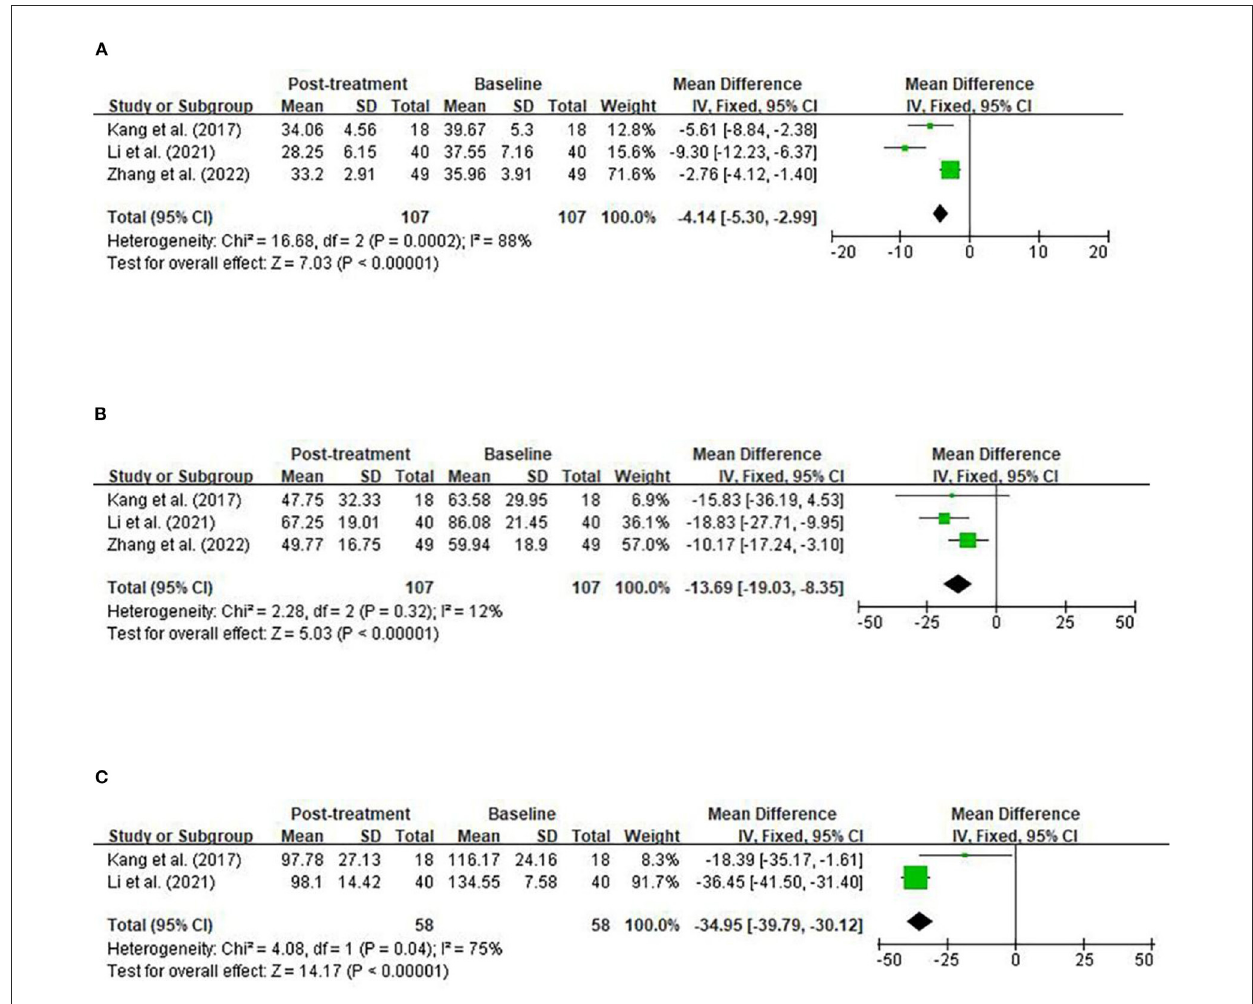
FIGUREA1 Fixed-effects meta-analyses of parental intervention on CARS (A) , ABC (B) , and SRS (C) . CARS, Childhood Autism Rating Scale; ABC, Autism Behavior Checklist; SRS, Social Responsiveness Scale; SD, standard deviation; CI, confidence interval; d.f., degrees of freedom; I 2 , I -square; Z ,